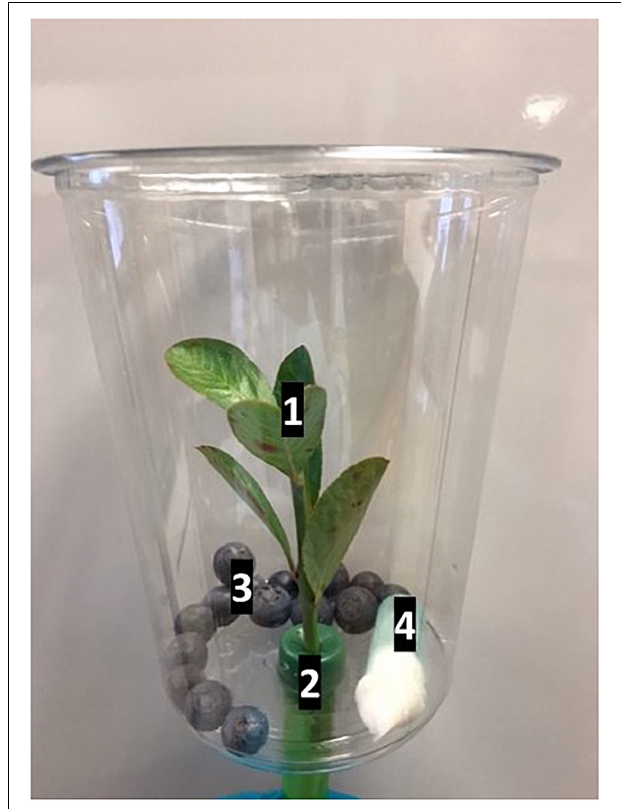
FIGURE 2 | The no-choice bioassay arena used in this study. The components of the no-choice bioassay arena include (1) a 5–7 cm long blueberry terminal with 4–5 leaves inserted into (2) a water pick, (3) 15 ripe organic blueberries, and (4) a Drosophila suzukii water